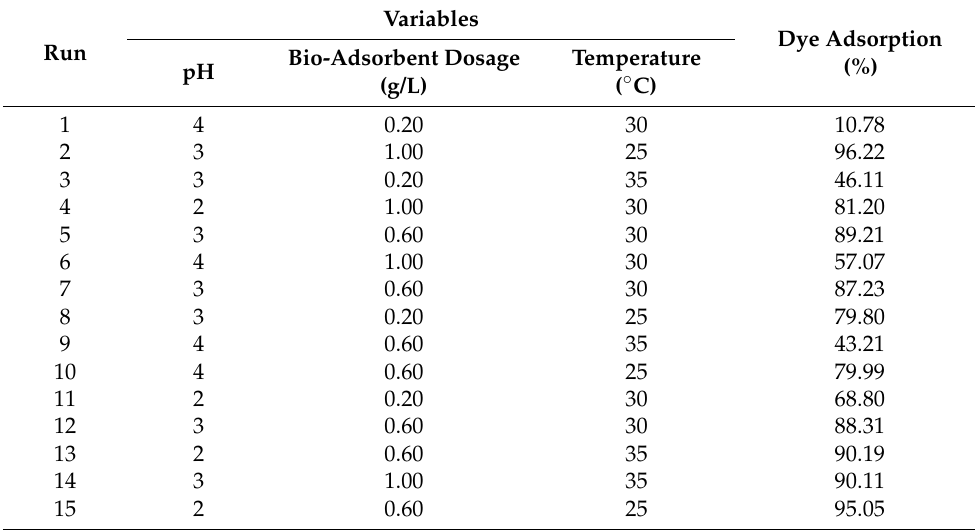
Table 3. Box–Behnken design for optimization of dye adsorption from TW by OS bio-adsorbent after 30 min of